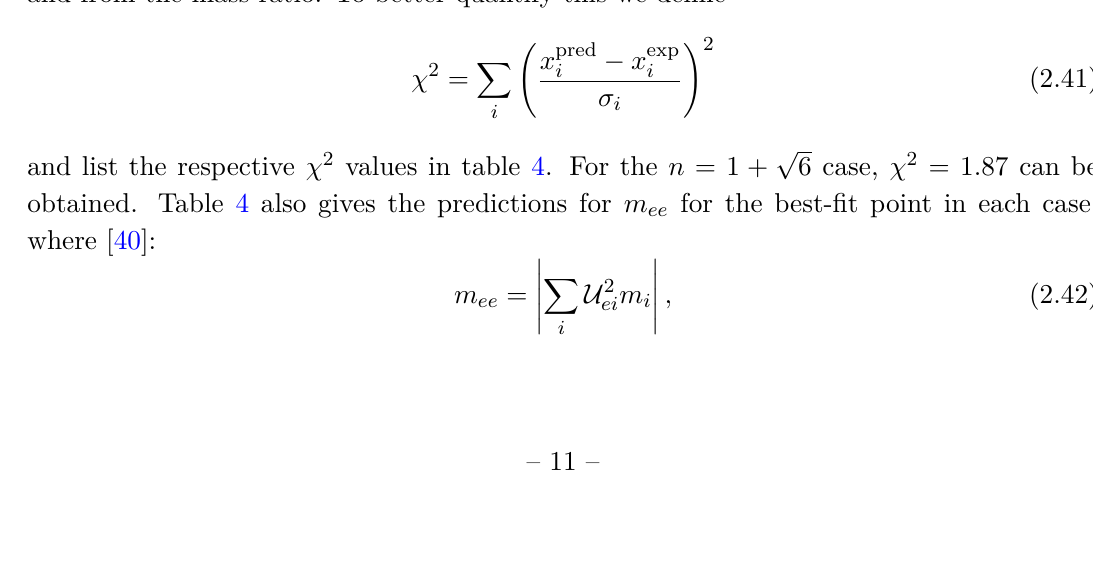
Figure 1 . Allowed 3 σ ( top ) and 1 σ ( bottom ) experimental ranges in the ( r, β ) plane using NuFit 5.1 values without SK atmospheric data for the n = 1+ case ( right ). The red circle indicates the best fit